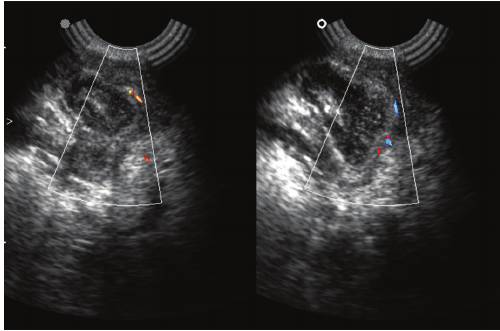
Figure 3: Color Doppler findings shows increased